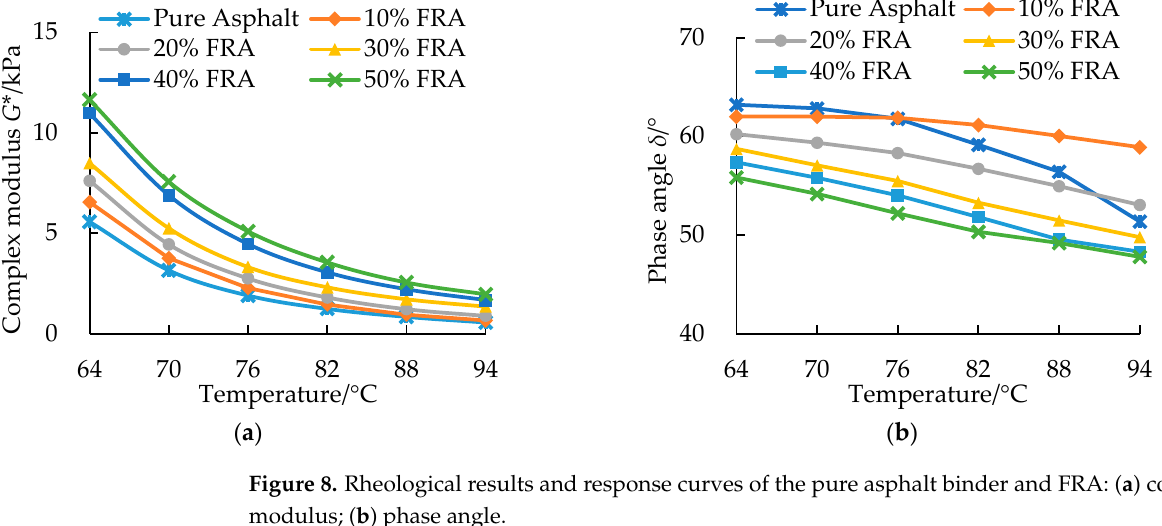
Figure 8. Rheological results and response curves of the pure asphalt binder and FRA: ( a ) complex modulus; ( b ) phase angle.